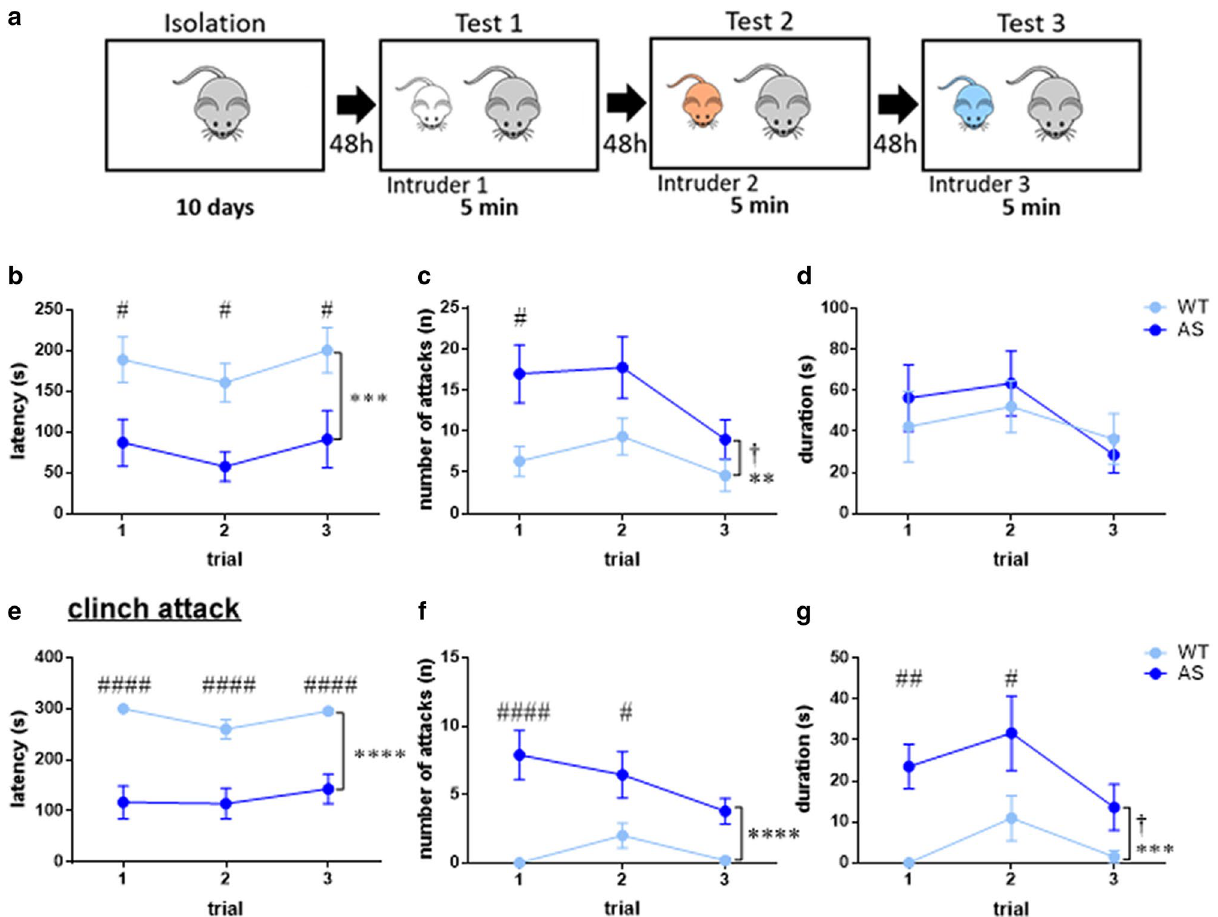
Figure 5. AS male mice display enhanced aggression in the resident-intruder test. ( a ) Illustration of the resident-intruder test. ( b – d ) Overall aggressive behavior is enhanced in AS mice. ( b ) The latency to the first attack. ( c ) Number of attacks during 5 min. ( d ) Total accumulative duration of attacks. ( e – f ) excessive uncontrolled aggression (clinch) is markedly predominant in AS male mice. ( e ) Latency to the first clinch attack. ( f ) Number of clinch attacks during 5 min. ( g ) Cumulative duration of clinch attacks. Line graphs represent mean ± SEM. N = 11 mice, N = 9 mice for WT and AS, respectively. # p < 0.05, ## p < 0.01, #### p < 0.0001 represent a genotype difference for each trial. ** p < 0.01, *** p < 0.001, **** p < 0.0001 represent an accumulative genotype effect. † p < 0.05 represents a trial